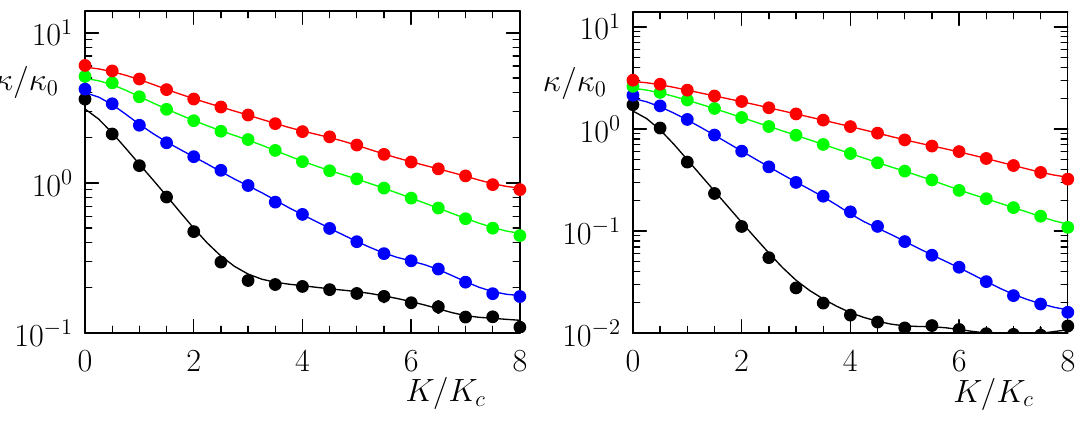
Figure A2. Dependence of the rescaled heat conductivity of the atom chain κ / κ 0 on the rescaled potential amplitude K / K c at different rescaled temperatures T / K c . The rescaled parameters are the same as in Figure A1. Here σ 0 = ν / ( 2 πη ) , κ 0 = σ 0 K c .